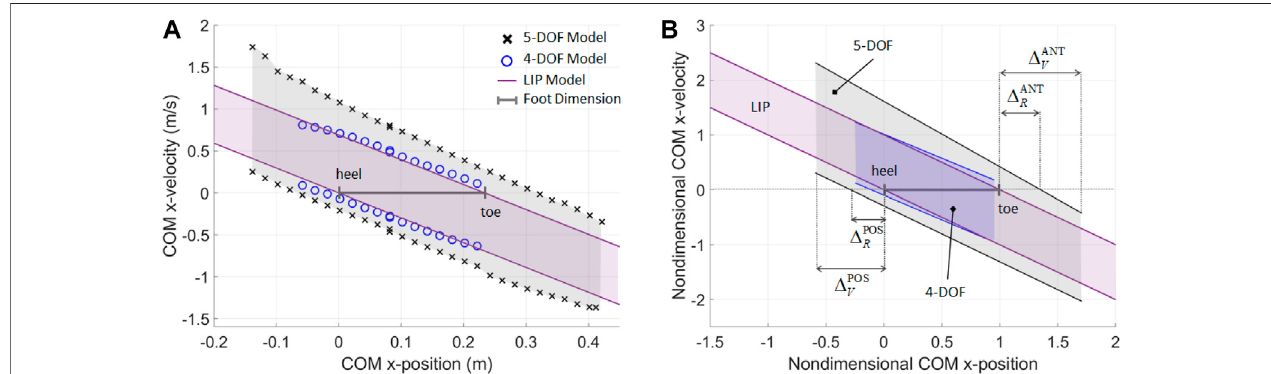
FIGURE 5 | (A) Numerical construction of the BoB for a reference subject in upright stance, when the subject ’ s body is modeled with a 5-DOF mechanism with a two-link foot, a 4-DOF mechanism with a rigid foot, and a 1-DOF LIP with fl at foot. (B) Nondimensional fi tted lines provide a general model of BoB for the three types of biped mechanism considered ( R 2 > 0.99). The nondimensional upper and lower BoB limits are − x ≤ _ x ≤ − x + 1 (LIP), − 0 . 89 x − 0 . 099 ≤ _ x ≤ − 0 . 88 x + 1 . 01 (4-DOF), and − 1 . 02 x − 0 . 29 ≤ _ x ≤ − 1 . 19 x + 1 . 61